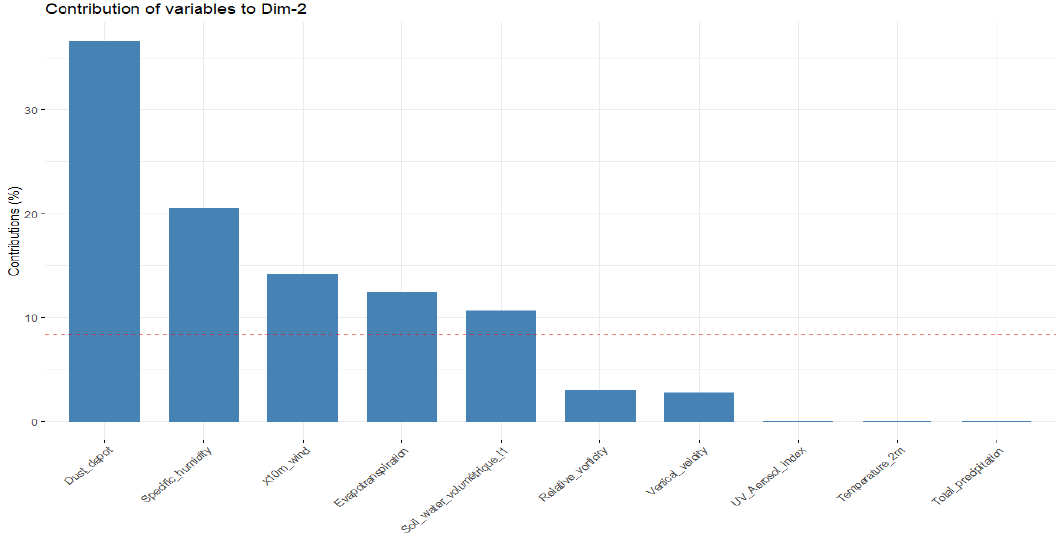
Figure 16. Diagram of the contribution of the variables in the PCA of the climatology of the studied parameters in relation to the second dimension.